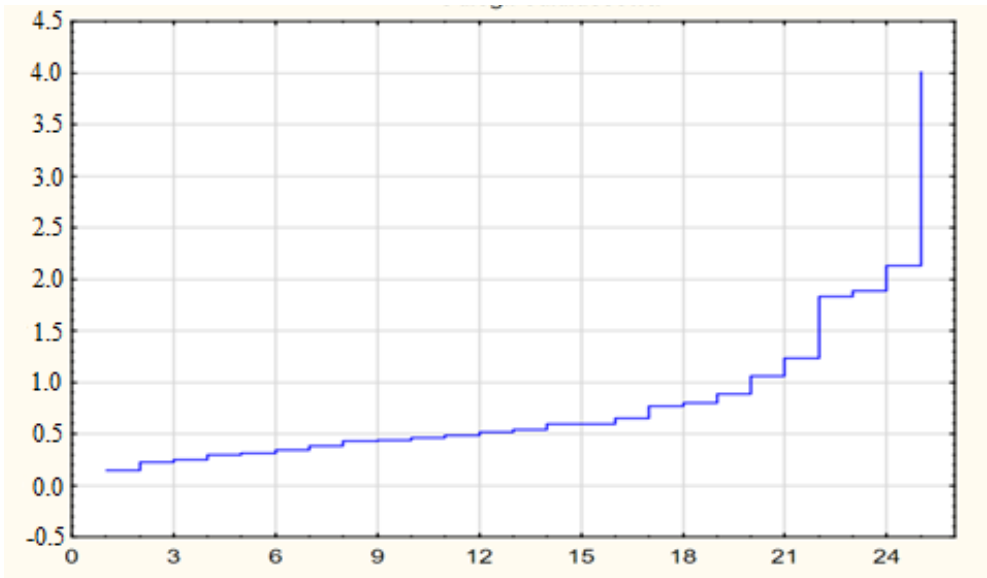
Figure 6. Binding distances relative to the binding stages. Source: (own elaboration). The values of means and standard deviations for standardized data for each member state are presented in Table 2. Table 2. Mean values and standard deviations for standardized data for 2018. Country